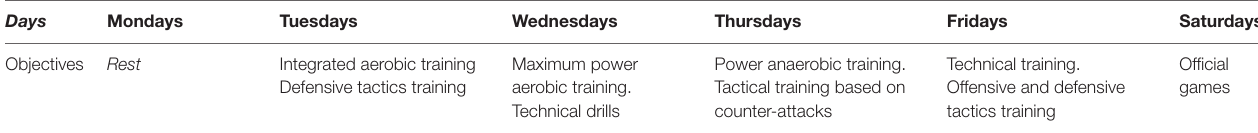
TABLE 1 | Details of general training routine during the week performed by both control and experimental groups over the 8 week intervention.